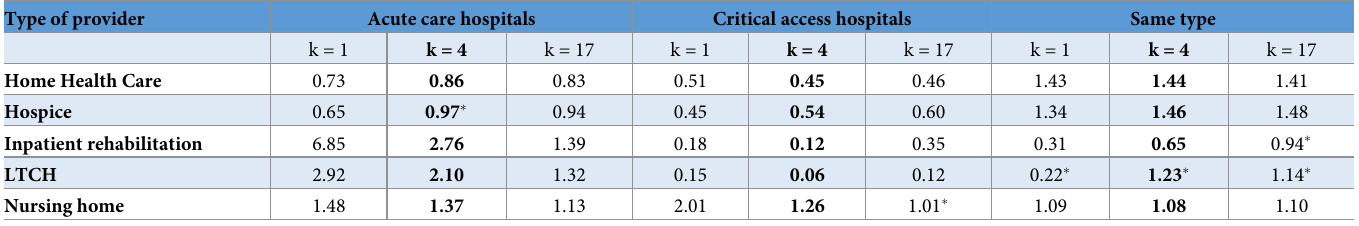
Table 2. Colocation quotients between types of providers and hospital facilities. Main analysis for an adaptive bandwidth of k = 4 nearest neighbors. Sensitivity analysis for k = 1 (the most conservative) and k = 17 (the least conservative scenario). Type of